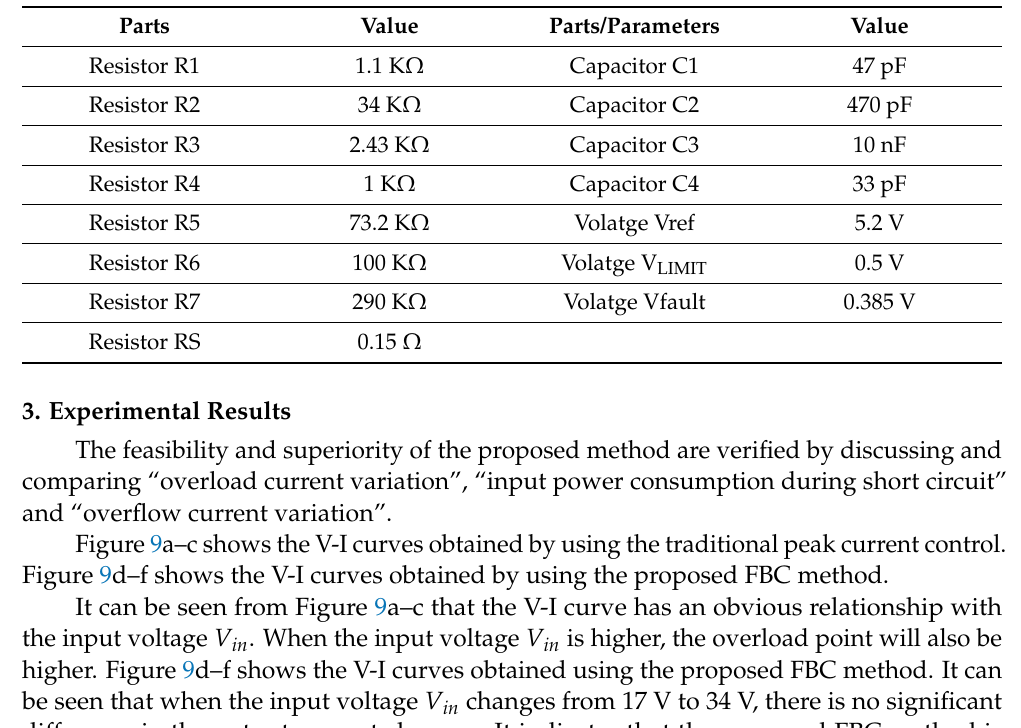
Table 2. The used components and parameters in the design